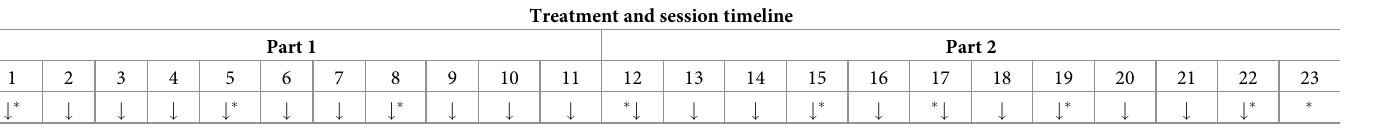
Numbers in the first row indicate consecutive days. Asterisks indicate experimental sessions, arrows indicate imipramine injections, performed either before or after– left and right with respect to the asterisk, respectively–experimental